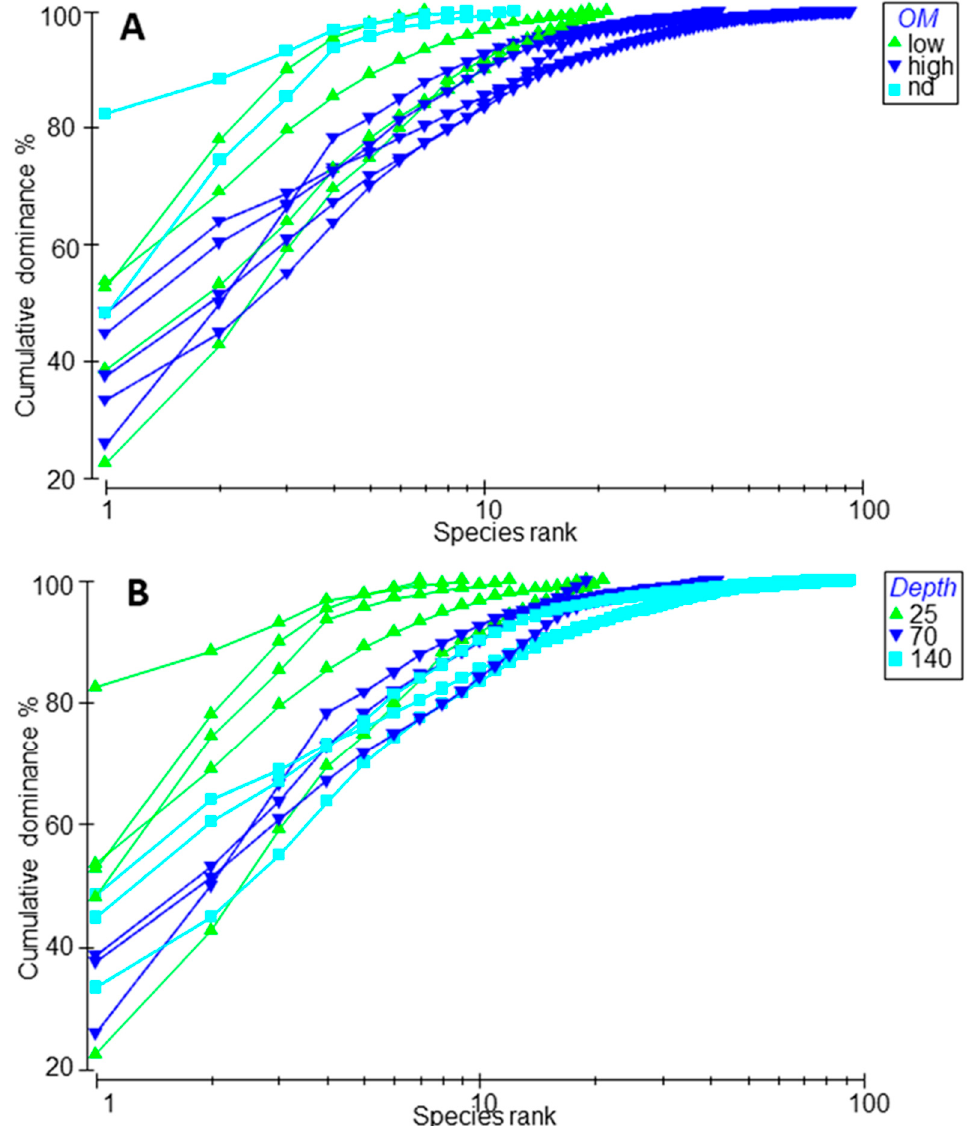
Figure 2. K-dominance curves for each analysed station show differences in OM ( A ) and depth ( B ) percentages.